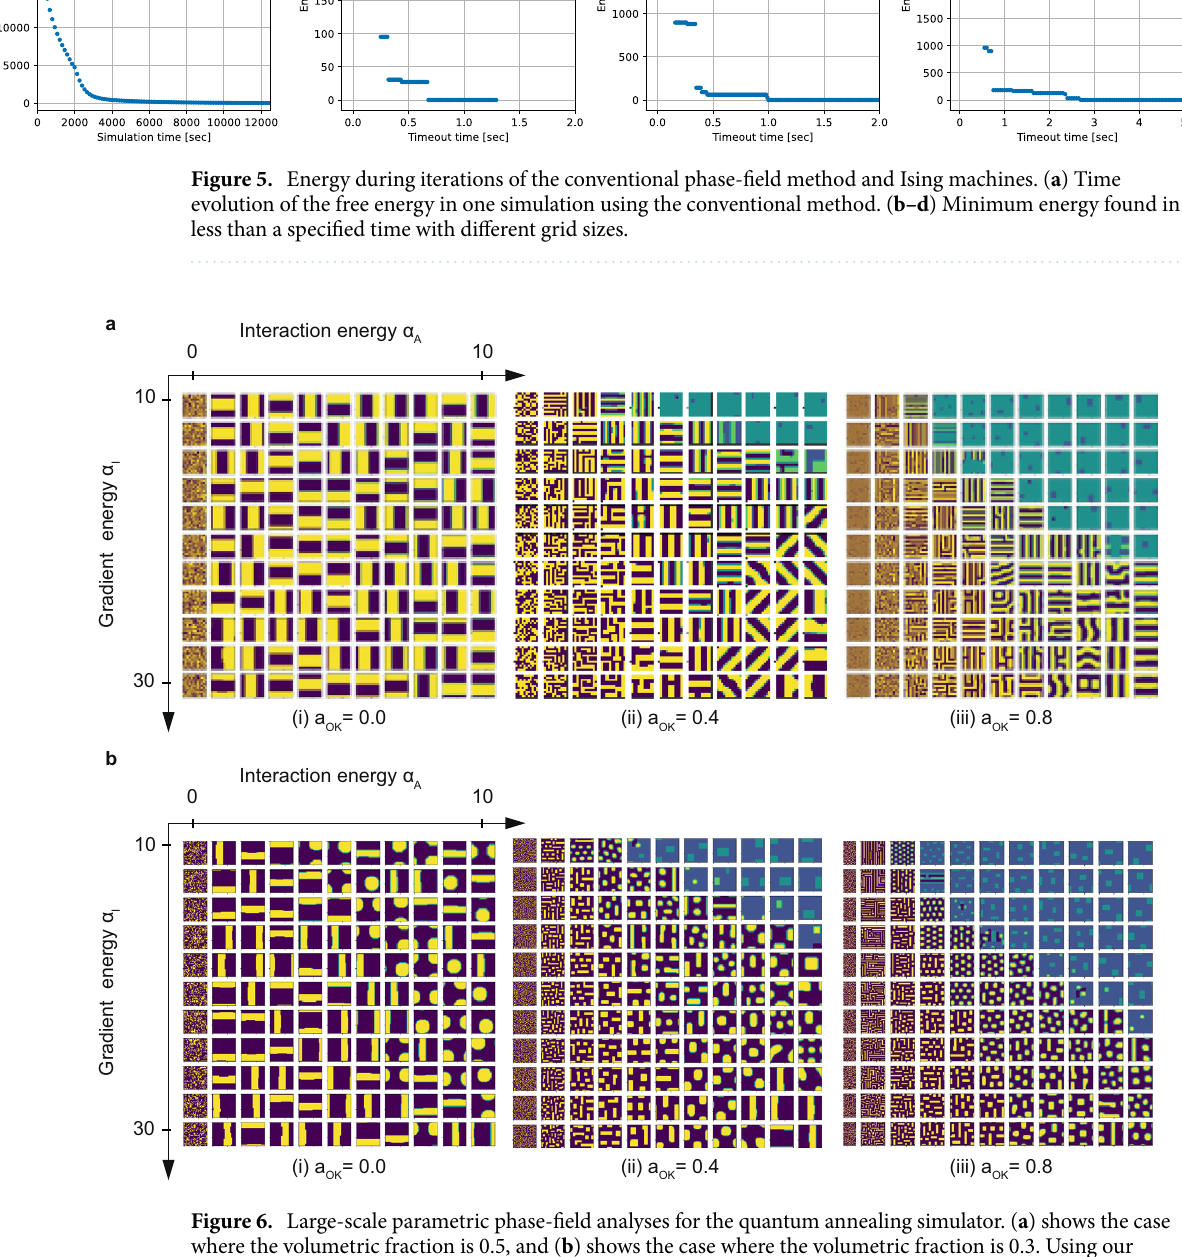
Figure 6. Large-scale parametric phase-field analyses for the quantum annealing simulator. ( a ) shows the case where the volumetric fraction is 0.5, and ( b ) shows the case where the volumetric fraction is 0.3. Using our proposed method, these simulations are completed in dozens of minutes. As for the previous simulation results, the microstructures are coincident with those in the phase